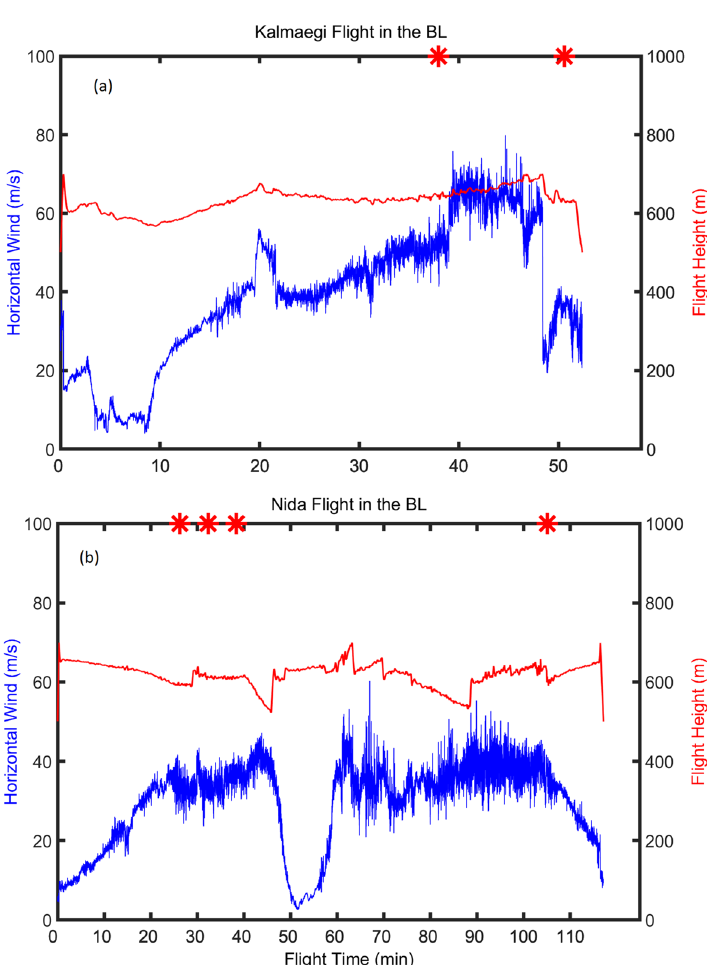
Figure 2. Time series of horizontal wind speed (blue) and aircraft altitude (red) in ( a ) Typhoon Kalmaegi and ( b ) Typhoon